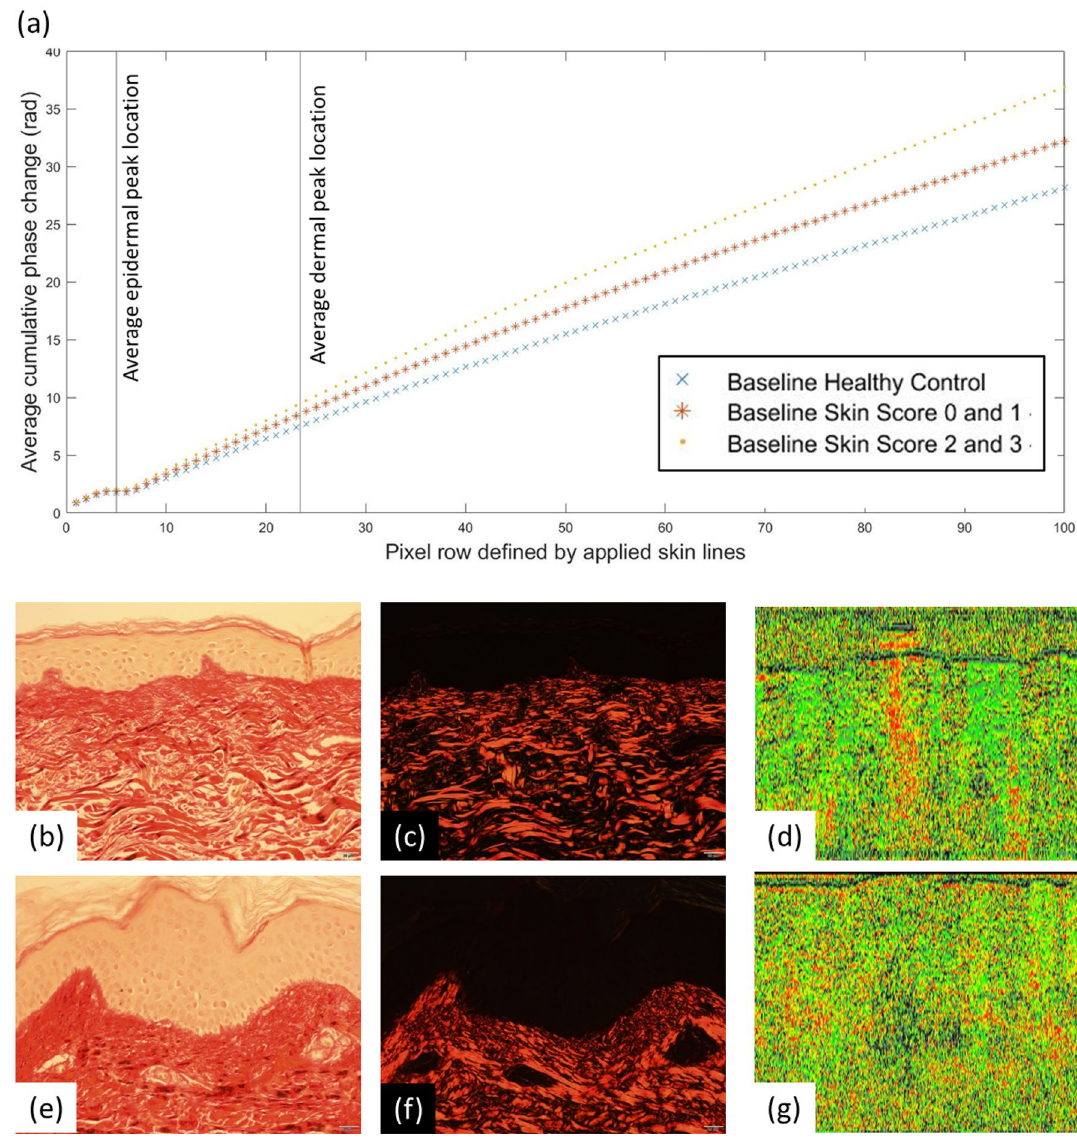
Figure 4. ( a ) Plot of baseline cumulative retardance with depth for HCs (N = 26) and patients with SSc grouped according to 0–1 (N = 24) and 2–3 (N = 7) skin score (shown without error bars, graphs with error bars provided in Supplemental data). Averaged locations for the epidermal and dermal peaks are denoted by the vertical grey lines. The graph indicates a higher gradient for patients with skin score 2–3 as compared to those with 0–1 and HCs. ( b ) PSR brightfield histology, skin score = 0–1; ( c ) PSR polarised histology, patient skin score = 0–1; ( d ) PS-OCT matching retardance images (arbitrary false colour); ( e – g ) corresponding imaging techniques in a patient with SSc (skin score = 2–3). Images ( d ) and ( g ) were generated in ThorImage